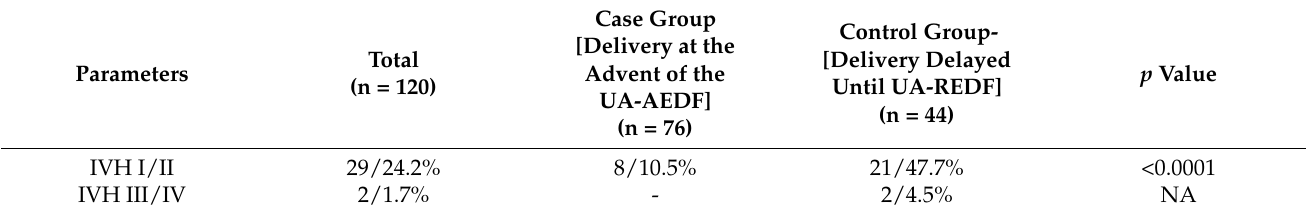
Table 9. Adverse fetal outcomes in infants born between 30 and 34 WG.